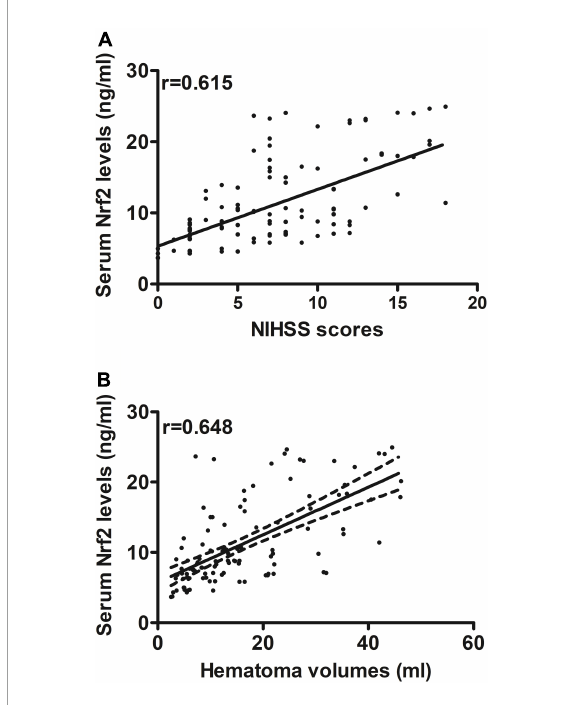
FIGURE3 Relationship between serum nuclear factor erythroid 2-related factor 2 (Nrf2) levels and stroke severity after acute supratentorial ICH. (A) Correlation of serum Nrf2 levels with National Institutes of Health Stroke Scale (NIHSS) score. (B) Correlation of serum Nrf2 levels with hematoma volume. Serum Nrf2 levels were closely and positively correlated with NIHSS score and hematoma volume (both P < 0.001). Nrf2 indicates nuclear factor erythroid 2-related factor 2; NIHSS, National Institutes of Health Stroke Scale.